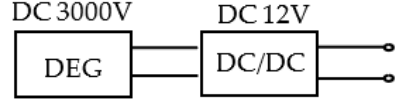
Figure 8. The 1500 V DC/DC converter. Figure 8. The 3000 V DC/DC converter.